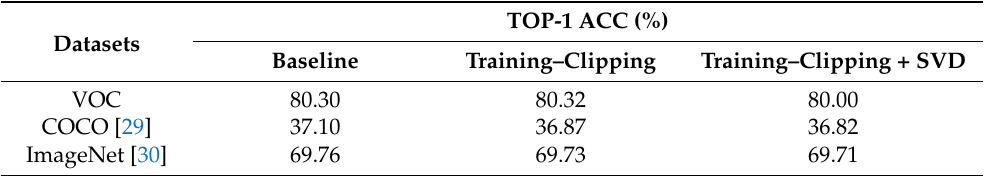
Table 9. Comparison with other